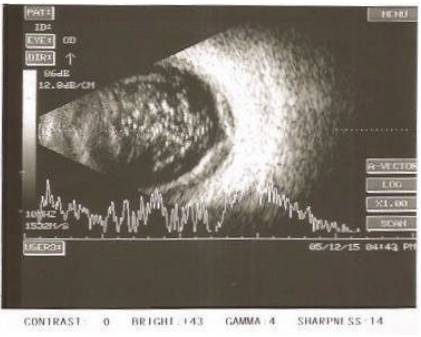
Figure 4: Left eye B-scan of Patient 2: ultrasonography shows asteroid hyalosis and shallow choroidal